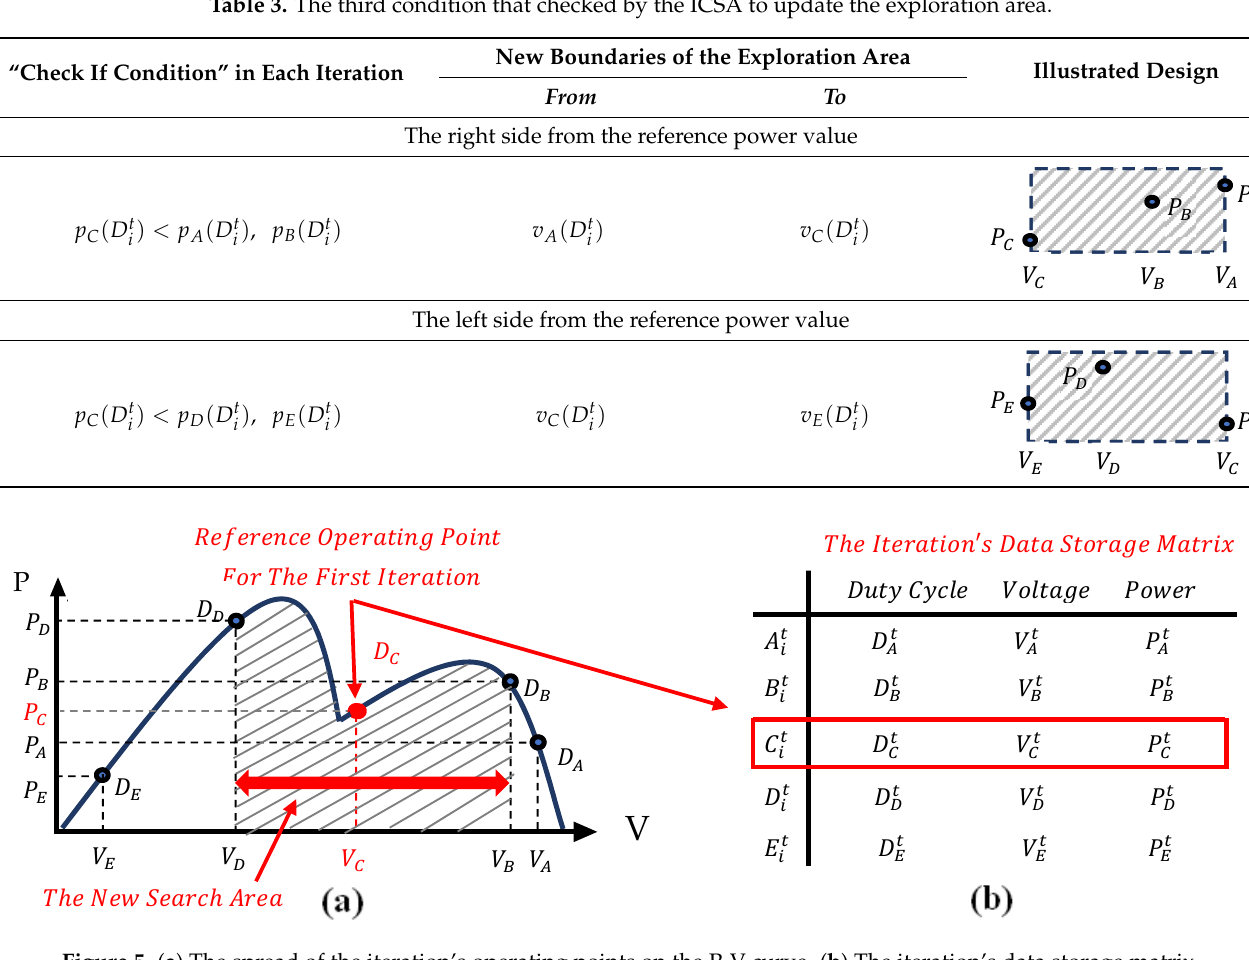
values. The matrix rows are marked by the characters (A, B, C, D, and E), as shown in Figure